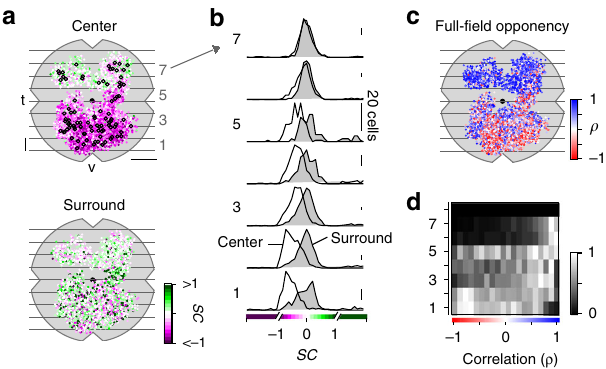
Fig. 6 Color-opponency at the level of the mouse retinal output. a Distribution of recorded ganglion cell layer (GCL) scan fi elds (black circles), with ROIs color-coded according to their center (top) and surround spectral contrast (SC; bottom). ROIs are scattered around scan fi eld center by ±300 µ m in x and y. Gray lines and numbers on the left indicate bins used for analysis in b , d . Bin size: 0.5 mm, scale bar: 1 mm. b Distribution of center (no fi ll) and surround (gray fi ll) SC values from ventral to dorsal retina. Numbers indicate bins shown in a . For all bins, center SC was signi fi cantly different from surround SC (Linear mixed-effects model for partially paired data; see Methods and Supplementary Methods). c Same as a , but color-coded according to full- fi eld opponency (min( ρ onset , ρ offset ); Methods). d Peak-normalized histograms showing distribution of correlation coef fi cient of full- fi eld opponency from ventral to dorsal retina. Numbers indicate bins shown in a . Bin size: 0.5